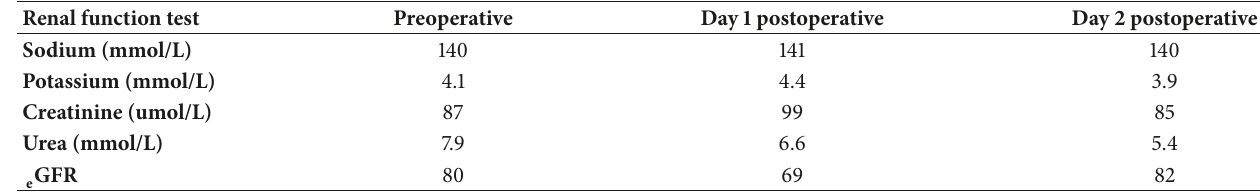
Table 2: Renal function tests of the